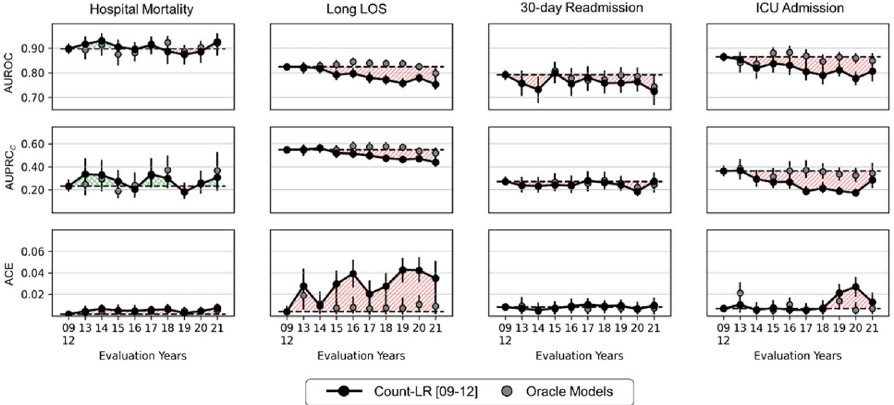
Figure 3. The impact of temporal distribution shift on the performance (AUROC, AUPRC C , and ACE) of logistic regression models trained on count-based representations (count-LR). Shaded regions indicate time windows in which performance in out-of-distribution years (2013–2021) is worse (red) or better (green) than performance in the in-distribution year group (2009–2012). A Larger red shaded region indicates more degradation relative to the model’s in-distribution performance. Oracle models were trained and evaluated on each of the out-of-distribution years. Error bars indicate 95% confidence interval obtained from 1000 bootstrap iterations. AUROC Area under the receiver operating characteristics curve; AUPRC C Calibrated area under the precision recall curve; ACE Absolute calibration error; LOS Length of stay; ICU Intensive care